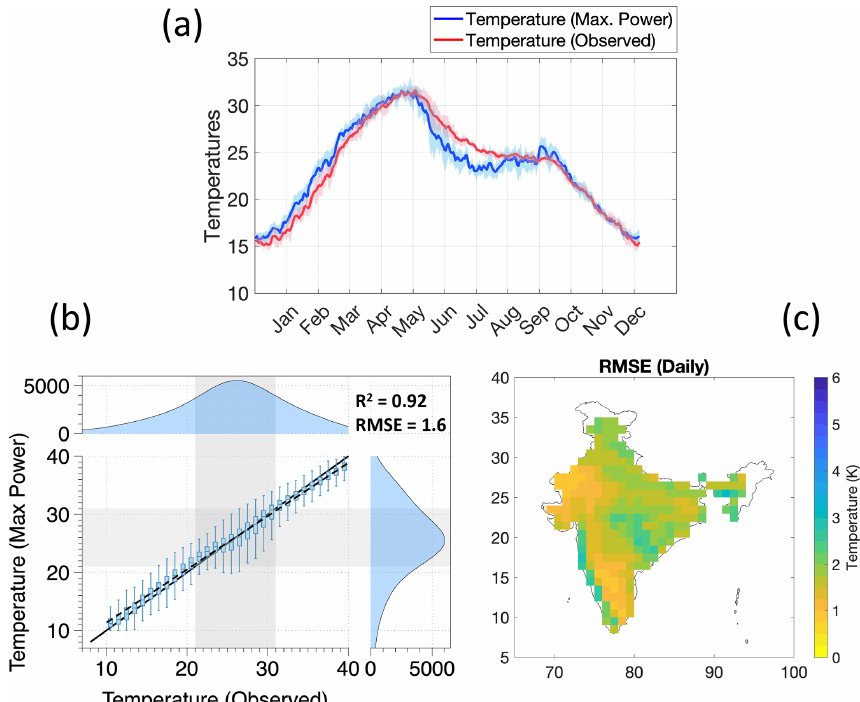
Figure 2. (a) Comparison of daily annual cycle of temperature for observed (Indian Meteorological Department, IMD) and estimated all-sky surface temperatures, averaged over all grid points. (b) Regression between the two temperatures at the grid-point scale. (c) Spatial variation of the root mean squared error (RMSE) in temperature estimates from maximum power compared to observed